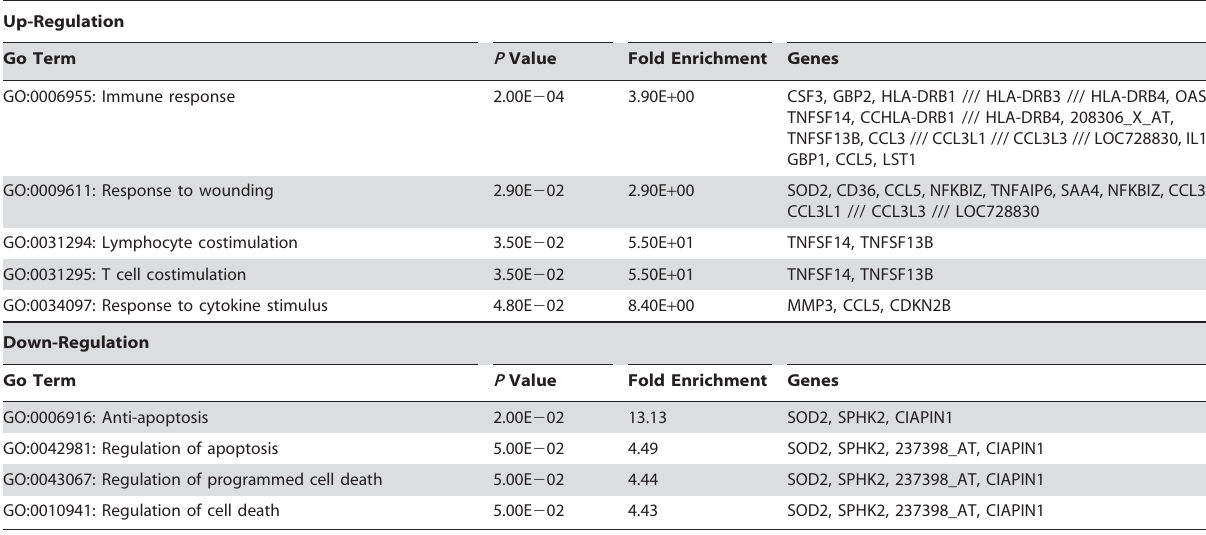
Table 2. The gene ontology (GO) identified by functional